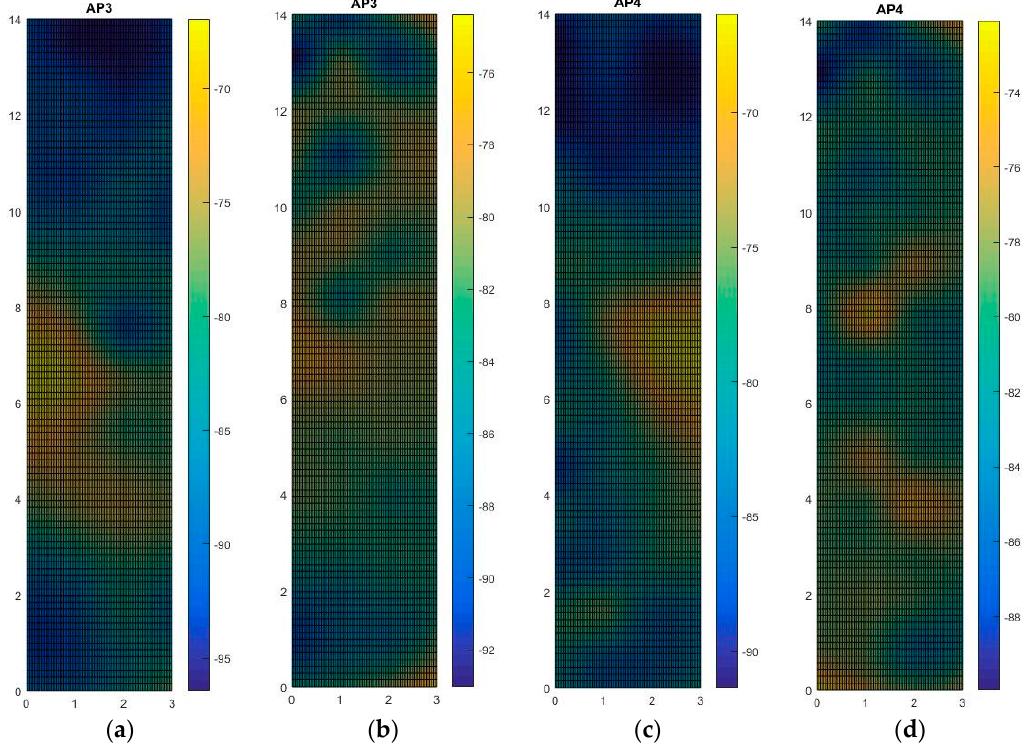
Figure 10. The RSS strength mapping of AP3 and AP4, ( a ) no students with AP3; ( b ) crowded students with AP3; ( c ) no students with AP4; ( d ) crowded students with AP4.